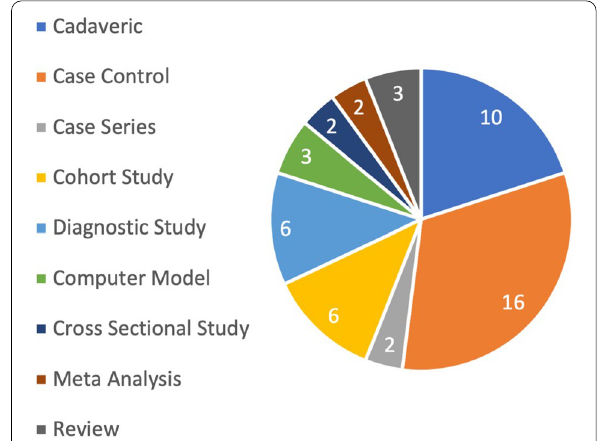
Fig. 3 The top 50 studies according to study